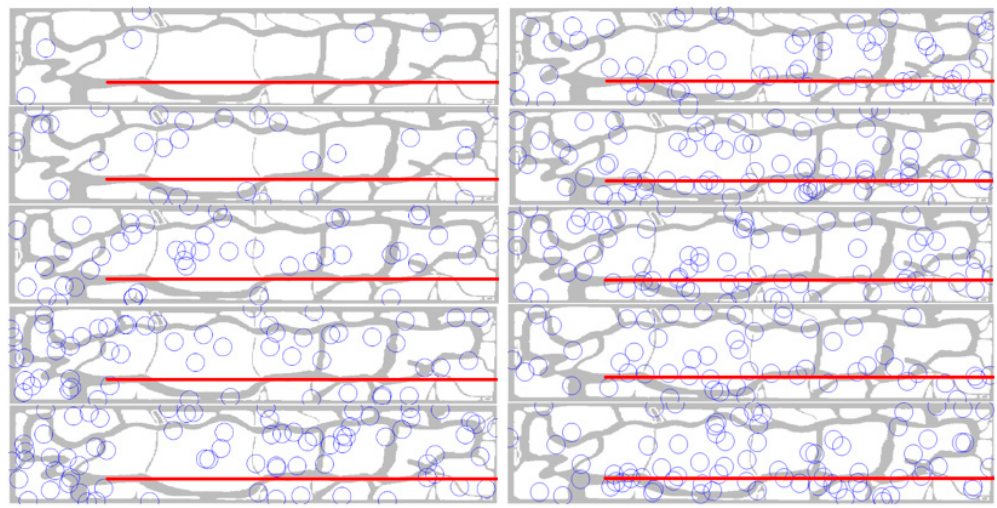
Figure 3. Behavior model verification: examples of results with low detection rates ( Left ) and high detection rates ( Right ) from the verification experiment (red line: UAS flight path, circles: positions of the radar).